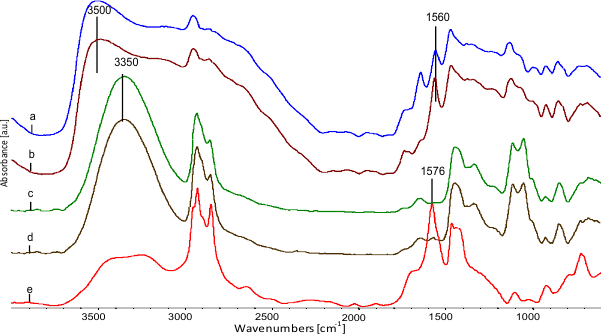
Figure 9. FTIR spectra of fibre spectra obtained by adding spectra of the following components: ( a ) A series, non-extracted; ( b ) B series, non-extracted; ( c ) A series, obtained as a result of the mathematical treatment of the percentage of components; ( d ) B series obtained as a result of the mathematical treatment of the percentage of components; ( e ) spectrum for sodium stearate.